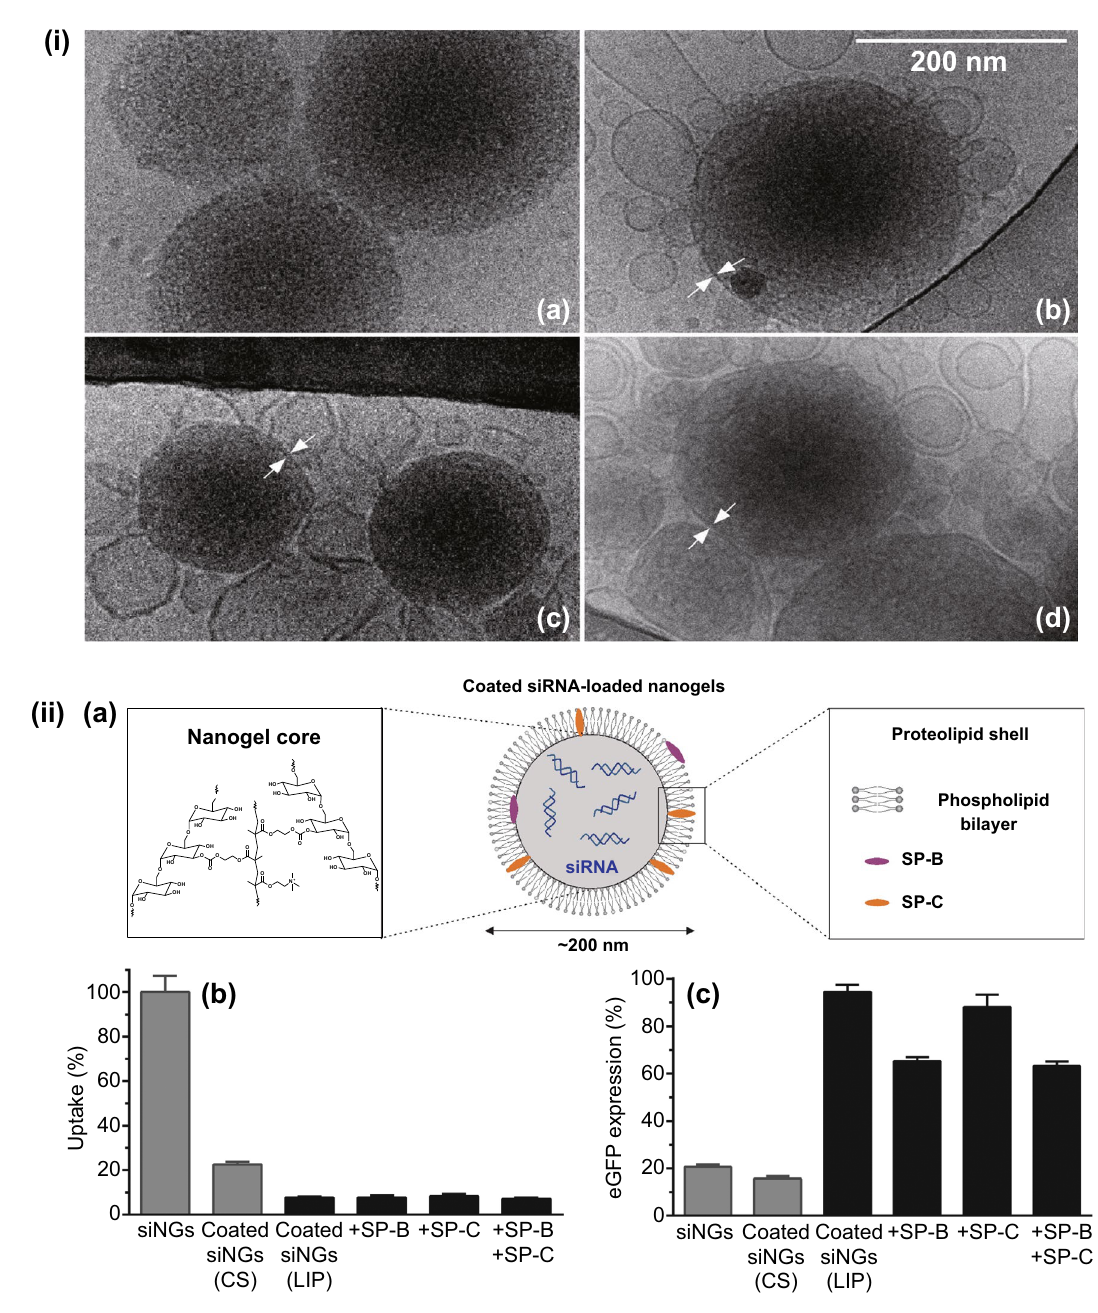
Fig. 6 (i) Cryo-TEM microimages of different nanoformulations: a uncoated, b Curosurf® coated. c DPPC:eggPG:SP-B-coated, and d DOPC:eggPG:SP-B-coated siRNA-loaded nanogels (siNGs). (ii) Proteolipid shell over the siNG core is depicted by white arrows. a Illustration of (proteo)lipid-coated siRNA-loaded nanogels (siNGs), b comparative cell uptake, and c gene silencing capacity of (siNGs) in H1299_eGFP cells determined employing flow cytometry. The siNGs were layered using DPPC:POPC:eggPG (50:35:15 wt%; the coated siNGs (LIP) and Curosurf® (coated siNGs (CS)) or in this LIP outer layer, SP-B (0.4 wt%) and/or SP-C (0.7 wt%) was incorporated. For cell uptake studies, the siRNA (siCy5) was tagged with fluorescent dye and their formulations wherein significant eGFP-targeting siRNA (siEGFP) normalization was observed as compared to EGF expression in animals treated with control siRNA (siCTRL). Adapted with permission from Ref. [320] with per- mission from Elsevier, Copyright